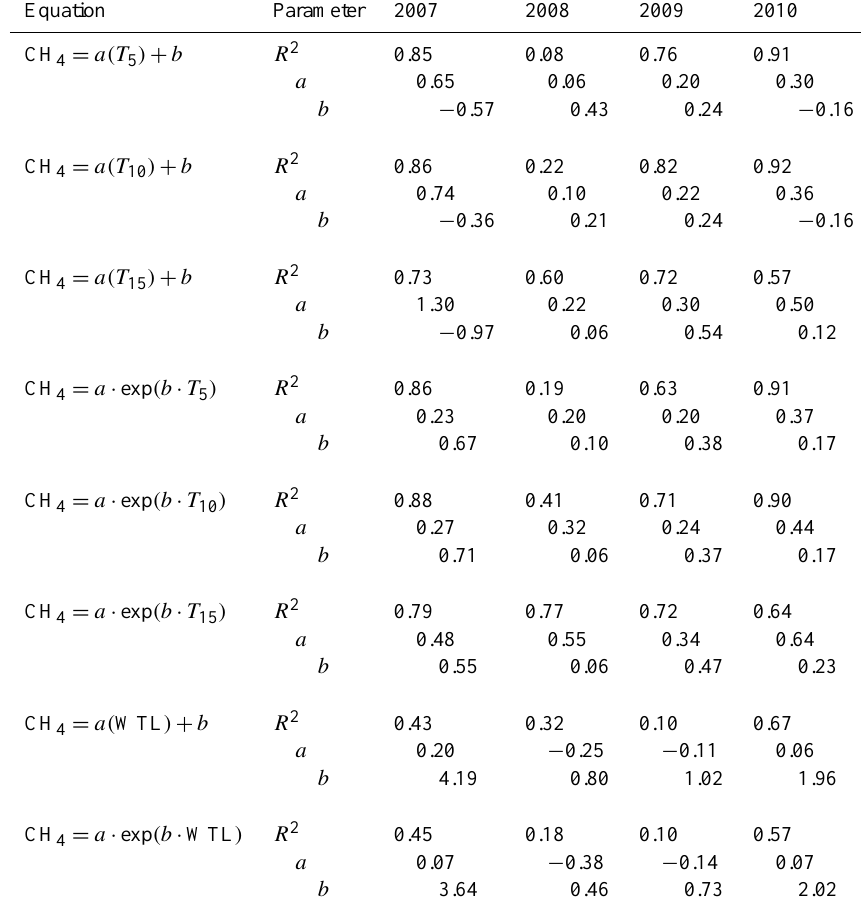
Table 3. Linear and exponential correlation parameters between growing season average CH 4 flux (CH 4 ) and growing season averages for soil temperature at 5, 10 and 15cm depths ( T 5 , T 10 and T 15 ) and water table level